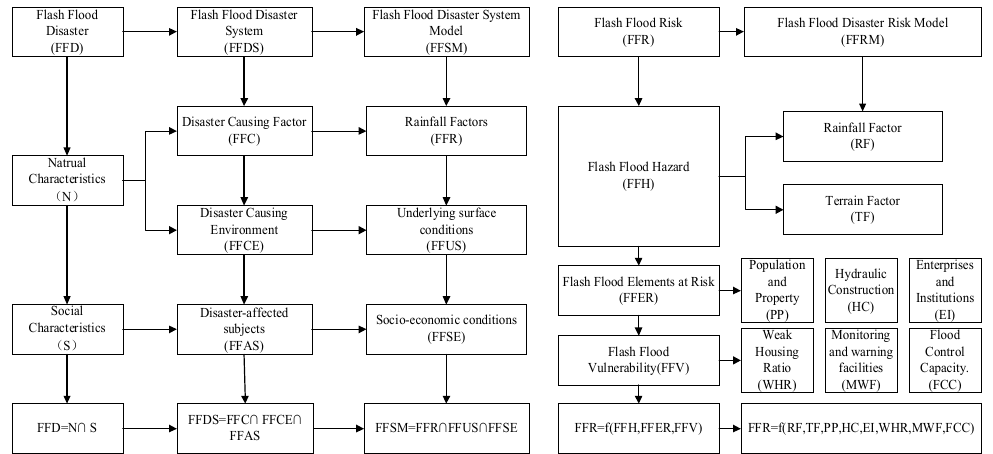
Figure 6. Conceptual Model of the Flash Flood Risk System.